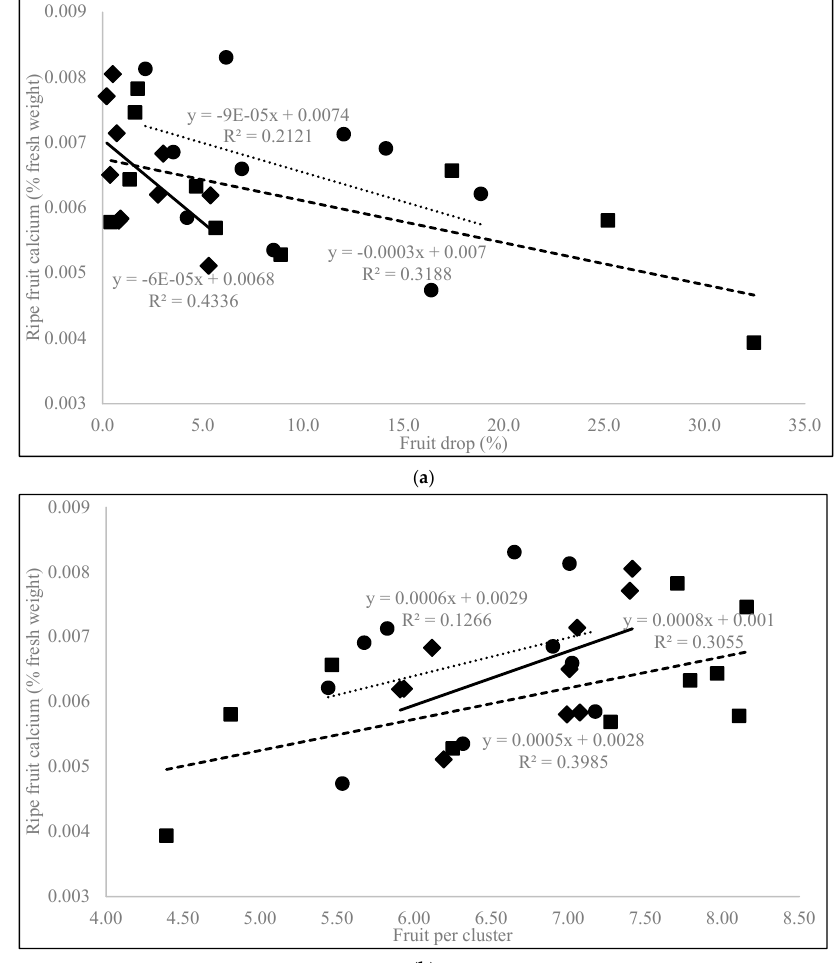
Figure 3. XY plots with regression equations and coefficients of determination between plant responses and fruit Ca concentration as affected by foliar Ca applications to ‘Draper’ highbush blueberry across three farm sites in the Fraser Valley, British Columbia, Canada in 2016 ( a ) Percent fruit drop versus ripe fruit calcium; ( b ) Fruit per cluster versus ripe fruit calcium, ● = Site 1 (do tt ed line), ◼ = Site 2 (dashed line), ◆ = Site 3 (solid line).